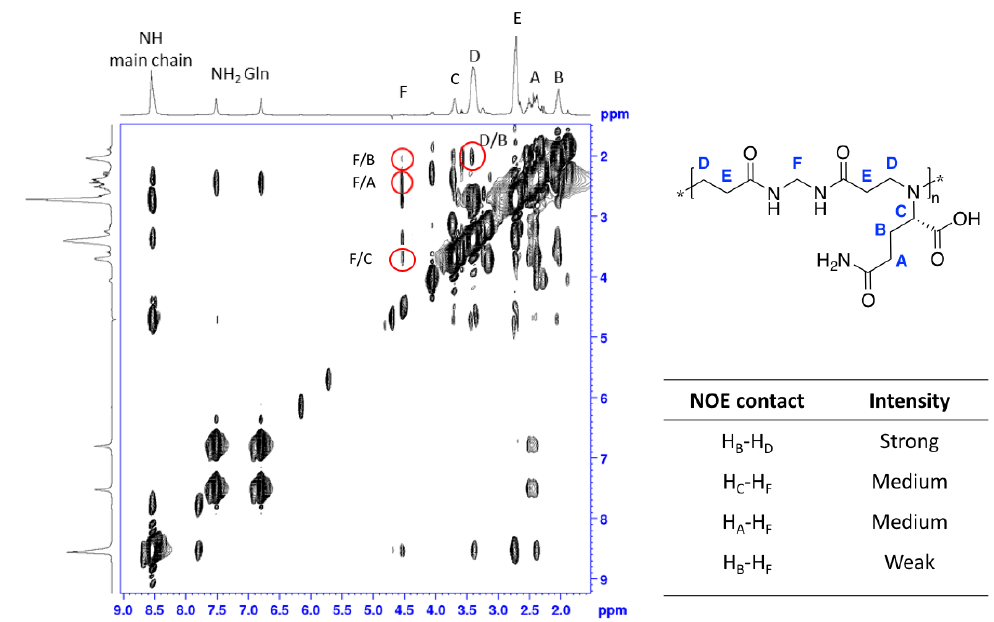
Figure 8. 2D-NOESY NMR spectrum of M- L -Gln recorded in 9:1 H 2 O:D 2 O at pH 4.5 and 298 K, using a Brüker Avance III 400MHz instrument.